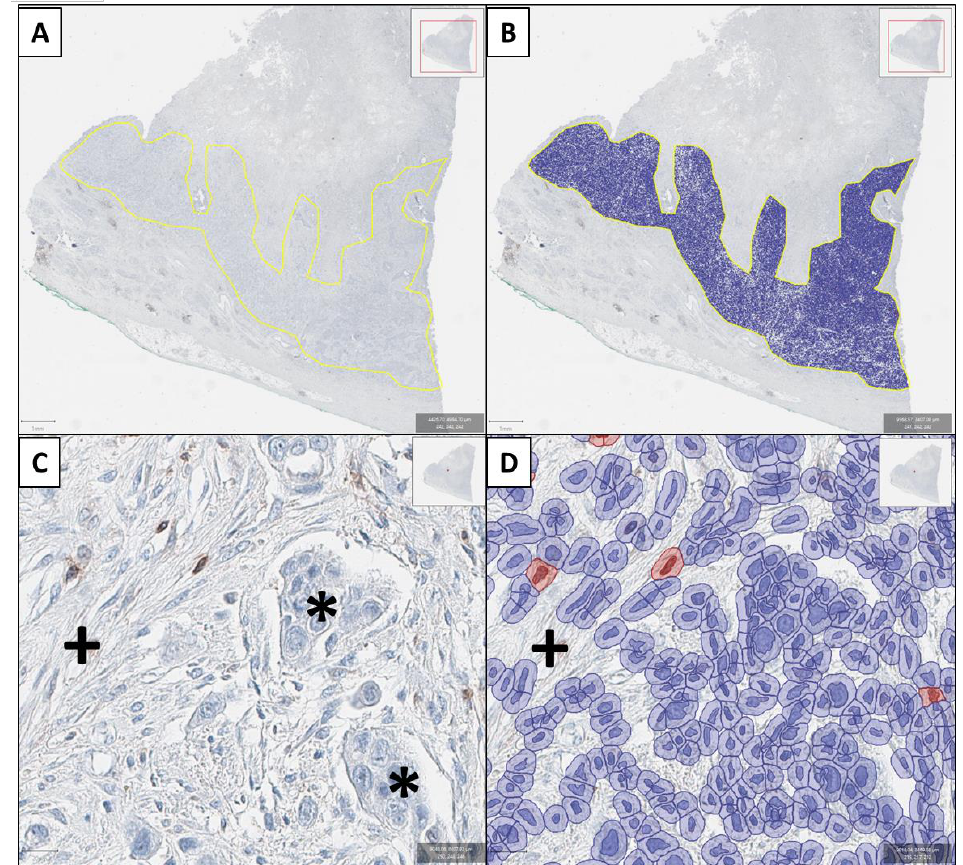
Figure 1. Example of the digital pathology approach (granzyme B immunostaining). In ( a ) the tumor area is identified by the genitourinary pathologist (HR) and after threshold adjustment, all cells are recognized ( b ). In ( c ) a tumor area showing cancer cells ( * ) and stromal cells ( + ) with few lymphocytes is shown. Only few lymphocytes show positive granzyme B-immunoreactivity with brown cytoplasmic staining and focal nuclear overlay. These cells are counted as positive (cells marked red in ( d ), while artificial brown background staining ( + ) is not recognized as a positive cell ( d ). Again, also all immunonegative cells are identified in ( d ) in hematoxylin staining.